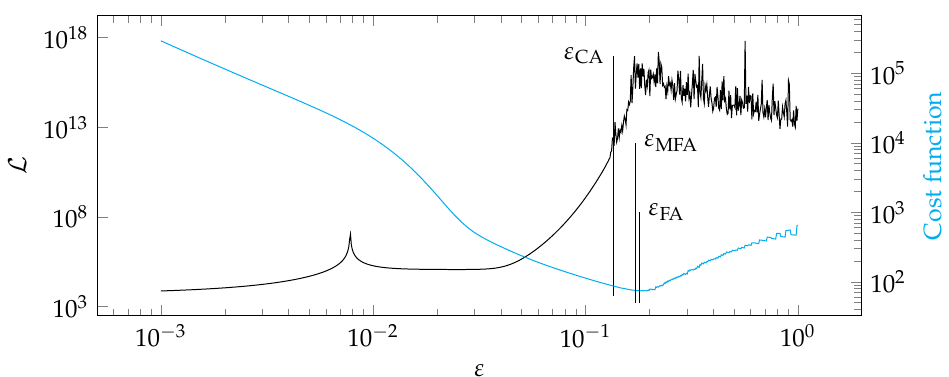
Figure 17. Graphs of the function L ( ε ) and the cost function for test case 2.